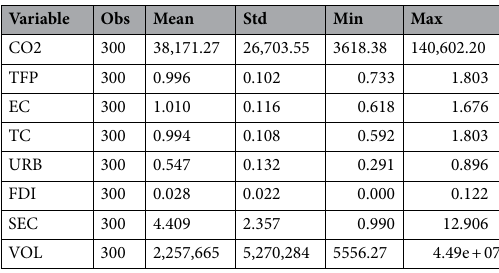
Table 3. Data description.